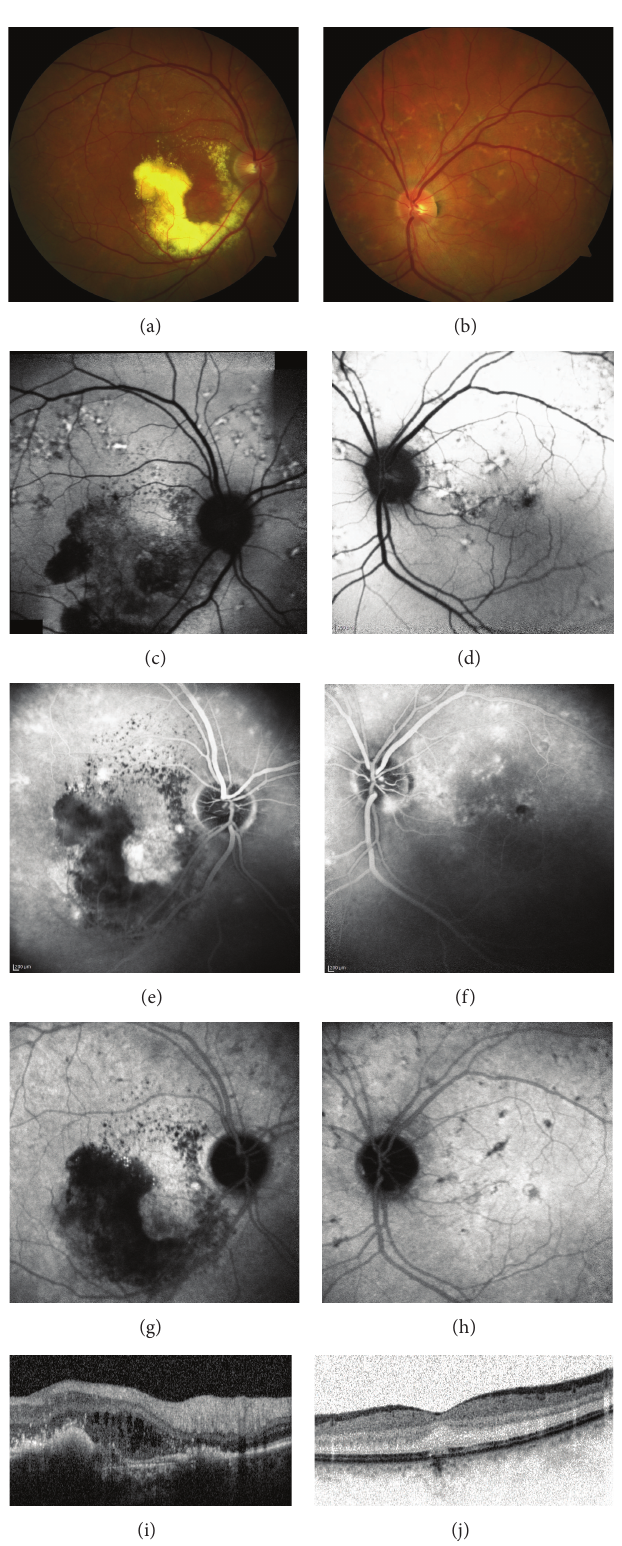
Figure 1: Colour fundus images of OD (a) and OS (b), fundus autofluorescent images of OD (c) and OS (d), venous phase of fluorescein angiography of OD (e) and OS (f), Indocyanine Green angiographic appearance of OD (g) and OS (h), and OCT sections of OD (i) and OS (j) at the time of our initial